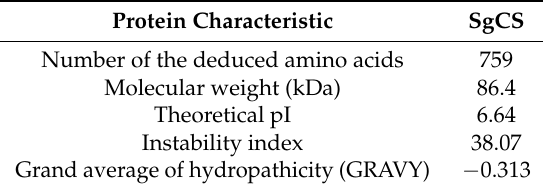
Table A1. Parameters computed by the online ExPASy Proteomics Server.